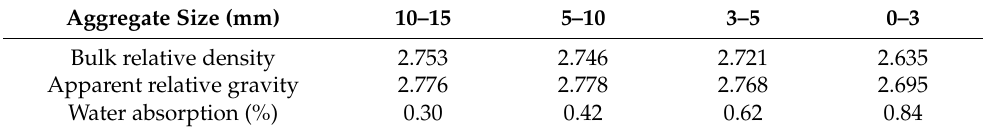
Table 3. Aggregate properties.